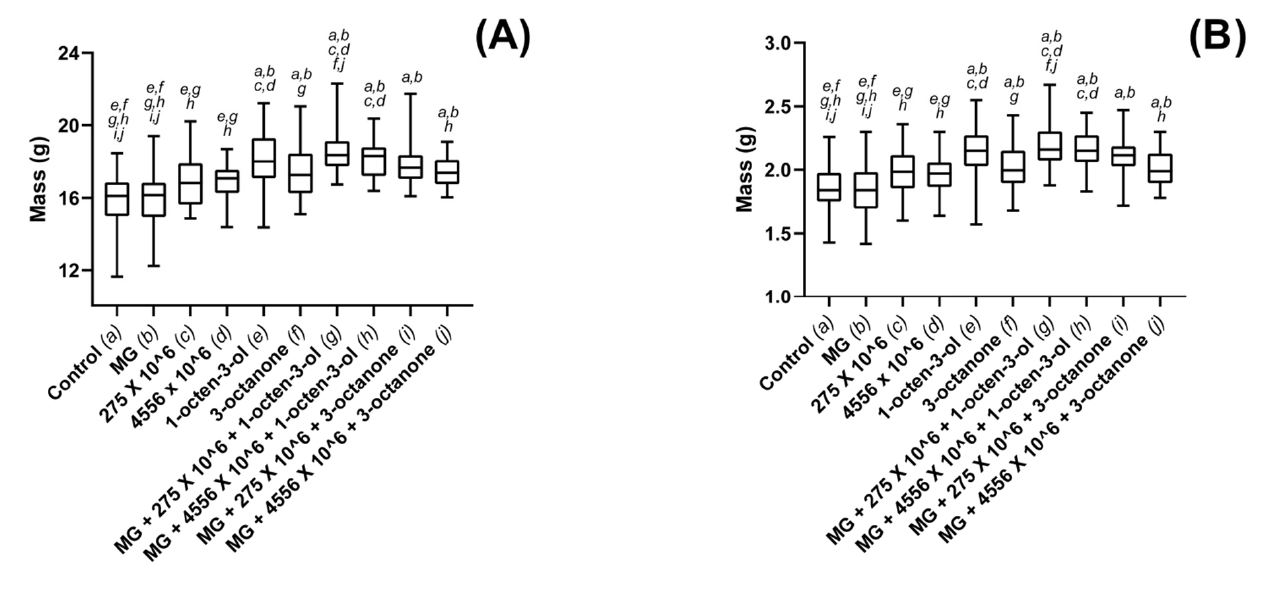
Figure 2. Total plant biomass (g) of Oilseed rape plants treated with different dosages of the Metarhiz- ium brunneum -derived VOCs: ( A ) 1-octen-3-ol and ( B ) 3-octanone. Whole plant fresh weights recorded for OSR exposed to different concentrations of 1-octen-3-ol and 3-octanone. Dosage rates are represented as µL per 100 g dry compost. Plants were grown in a glasshouse maintained at 25 ± 2 °C for a total of six weeks. Controls were exposed to compost media without additional treat- ment. Figure display’s minimum, 1st quartile, median, 3rd quartile and maximum measurements within the treatment group. Significant results denoted between treatments using letters ( a – e ) above each boxplot; where denotation letters are absent, no significant differences were detected between treatments.